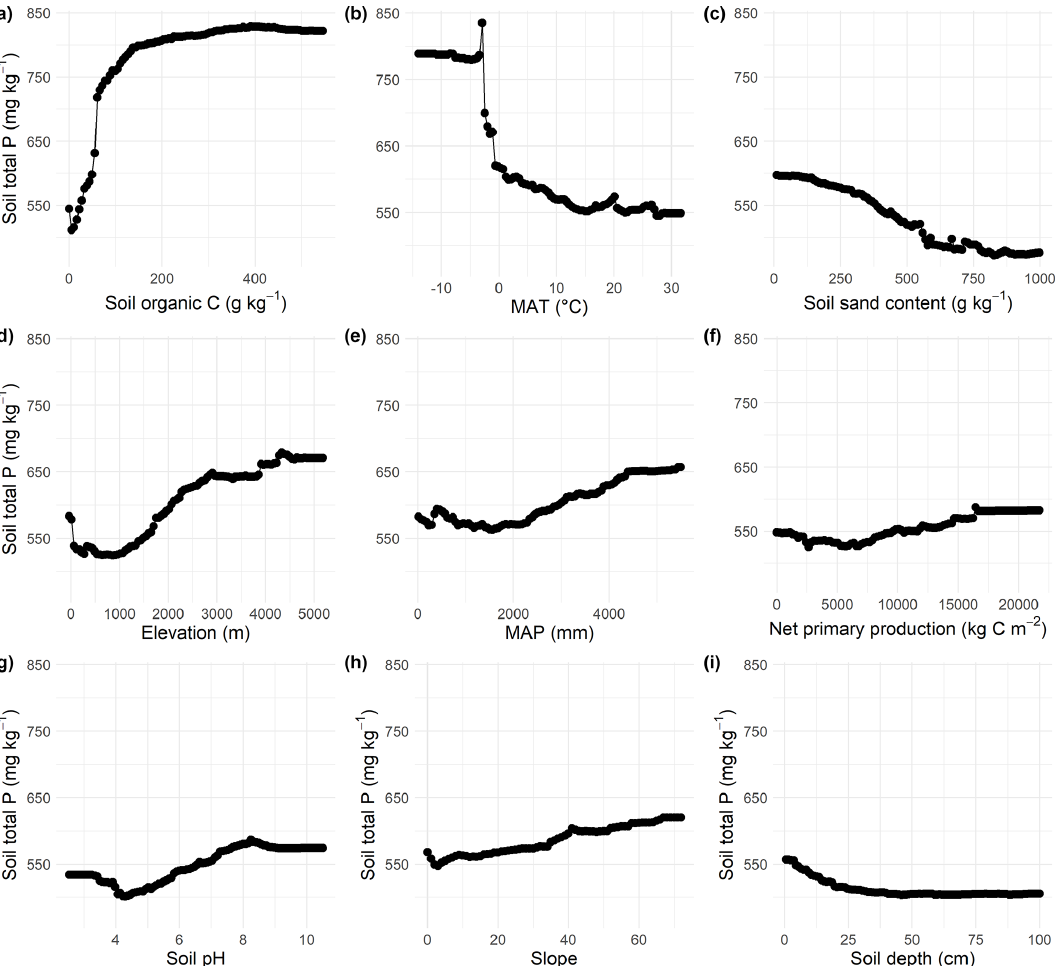
Figure 4. Partial dependence plots showing the dependence of soil total P concentration on predictors. Soil total P concentration in relation to (a) SOC concentration, (b) MAT, (c) soil sand content, (d) elevation, (e) MAP, (f) net primary production, (g) soil pH, (h) slope, and (i) soil